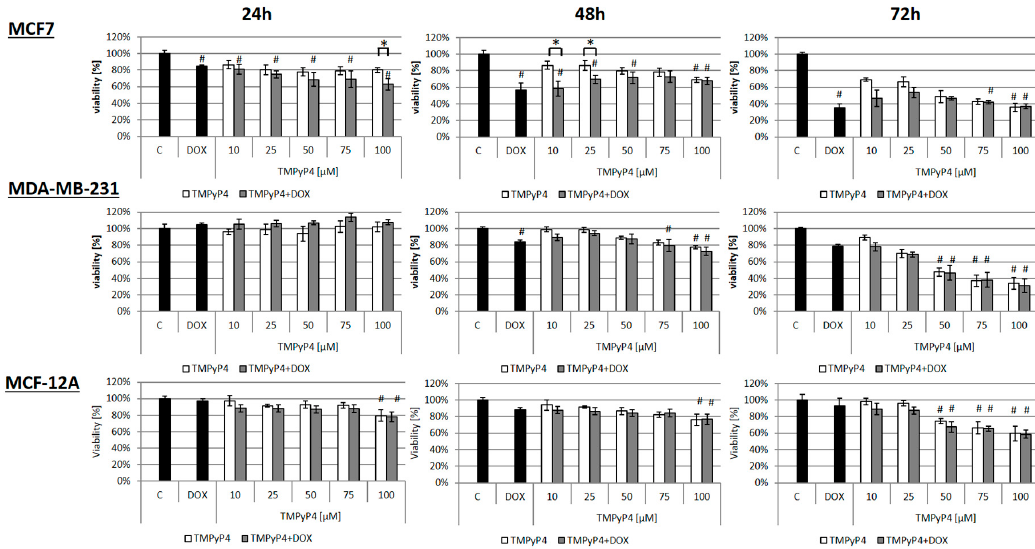
Figure 1. Cancer cell survival after exposure to telomerase inhibitor, TMPyP4. MCF7, MDA-MB-231, and MCF-12A cells were exposed to different concentrations of TMPyP4 (10–100 µM; open bars), doxorubicin (DOX, 0.1 µM) or a combination of both compounds (grey bars) for 24, 48, or 72 h. The viability was assessed using MTT assay. Cell survival was assessed relative to the control sample (C). * p < 0.05, TMPyP4 relative to TMPyP4+DOX; # p < 0.05, relative to control sample. Tests were performed in biological triplicates (each replicate consisted of 8 technical replicates/wells).